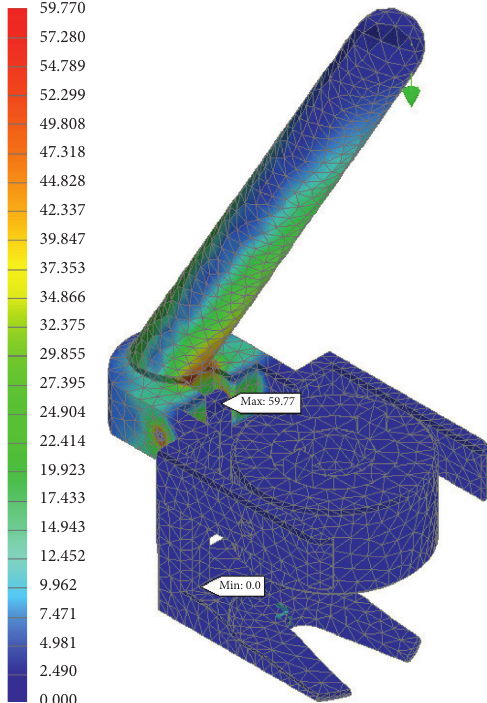
Figure 10: Simulation results showing von Mises stress.